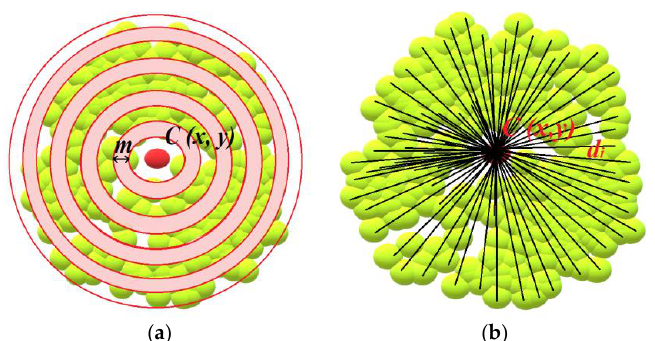
Figure 6. Analysis of the distribution of the points in the point cloud in relation to centroid C i : ( a ) Searching the point cloud in belts p i of a fixed width m ; ( b ) The determination of the position of the